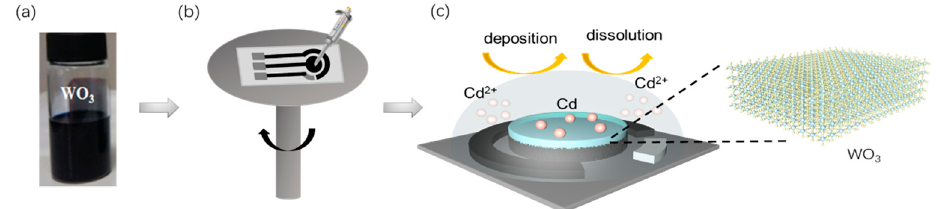
Figure 1. Schematic diagram of WO 3 -modified electrode for Cd 2+ sensor. ( a ) WO 3 nanocrystal solution; ( b ) The electrode modification process with WO 3 nanocrystals by spin-coating; ( c ) Ion adsorption and desorption process.